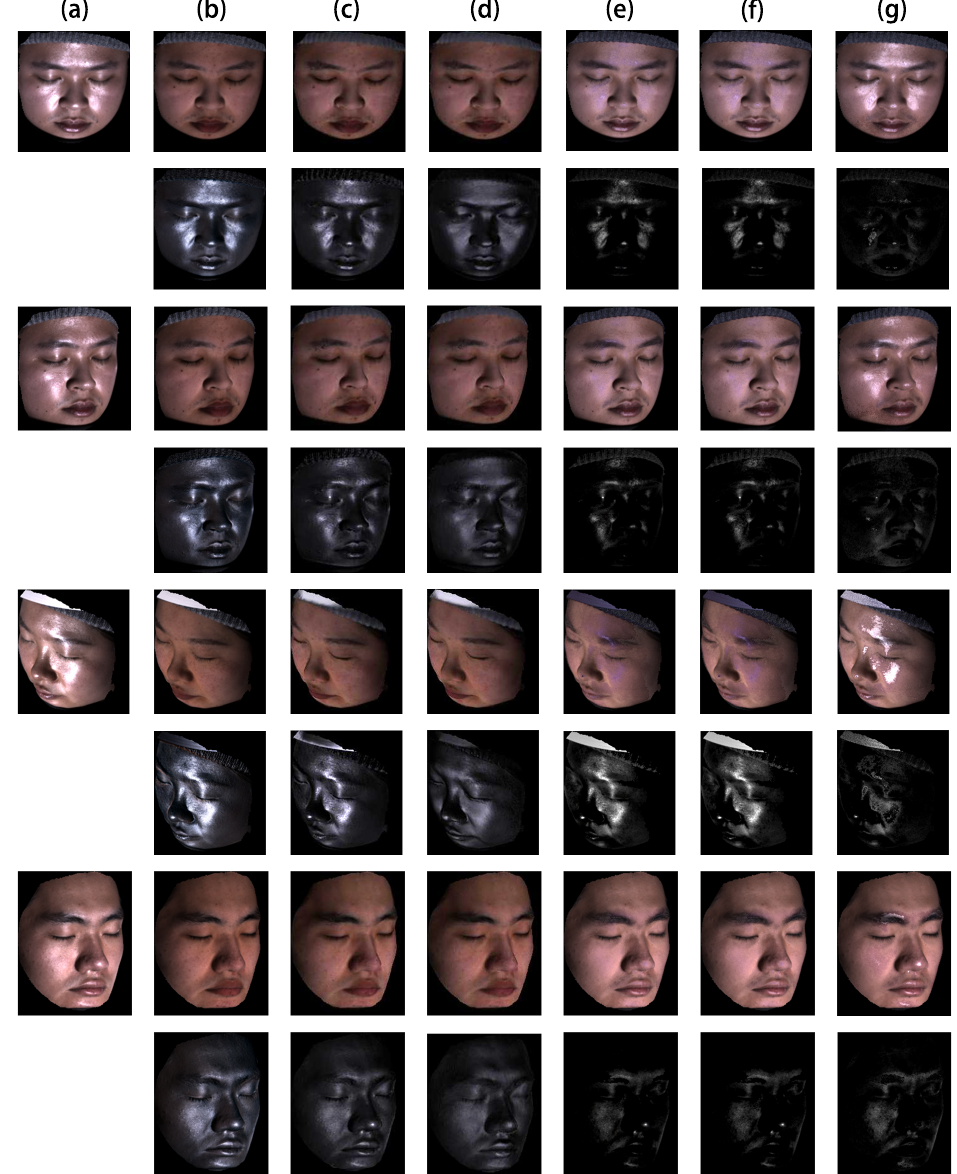
Figure 4. Qualitative evaluation of highlight removal on the Laboratory Captured Dataset. ( a ) In- put images. ( b ) Ground truth diffuse and specular components obtained by cross-polarization. ( c – g ) Separated diffuse and specular components by ( c ) our method based on dichromatic reflection model, ( d ) our method based on mirror reflection model, ( e ) [58], ( f ) [59], and ( g ) [29]. The specular component is rescaled by two for better